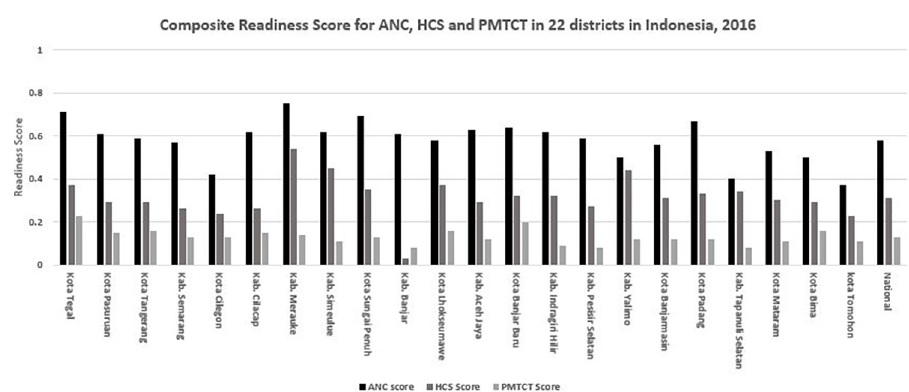
Fig 4. Composite readiness scores for ANC, PMTCT and HCS, by districts, 2016. Note: ANC: antenatal care; PMTCT: Prevention of Mother-to-Child Transmission; HCS: HIV care and support. Four variables in ANC service indicators are excluded from calculation since the comparable variable are not available for private facilities–these are guidelines and staff trained in ANC, and the availability of folic acid tablets and tetanus toxoid vaccine.